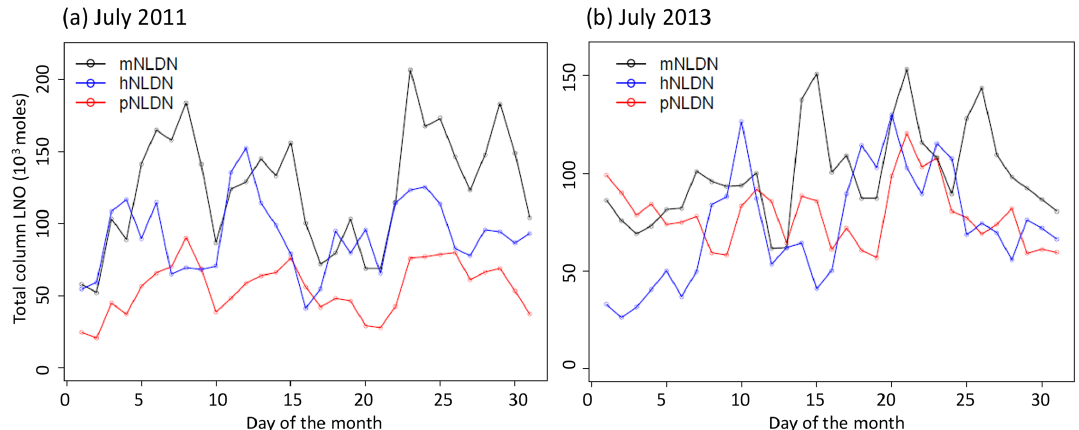
Figure 10. Total daily column LNO over the model domain with different LNO production schemes for (a) 2011 and (b) 2013.